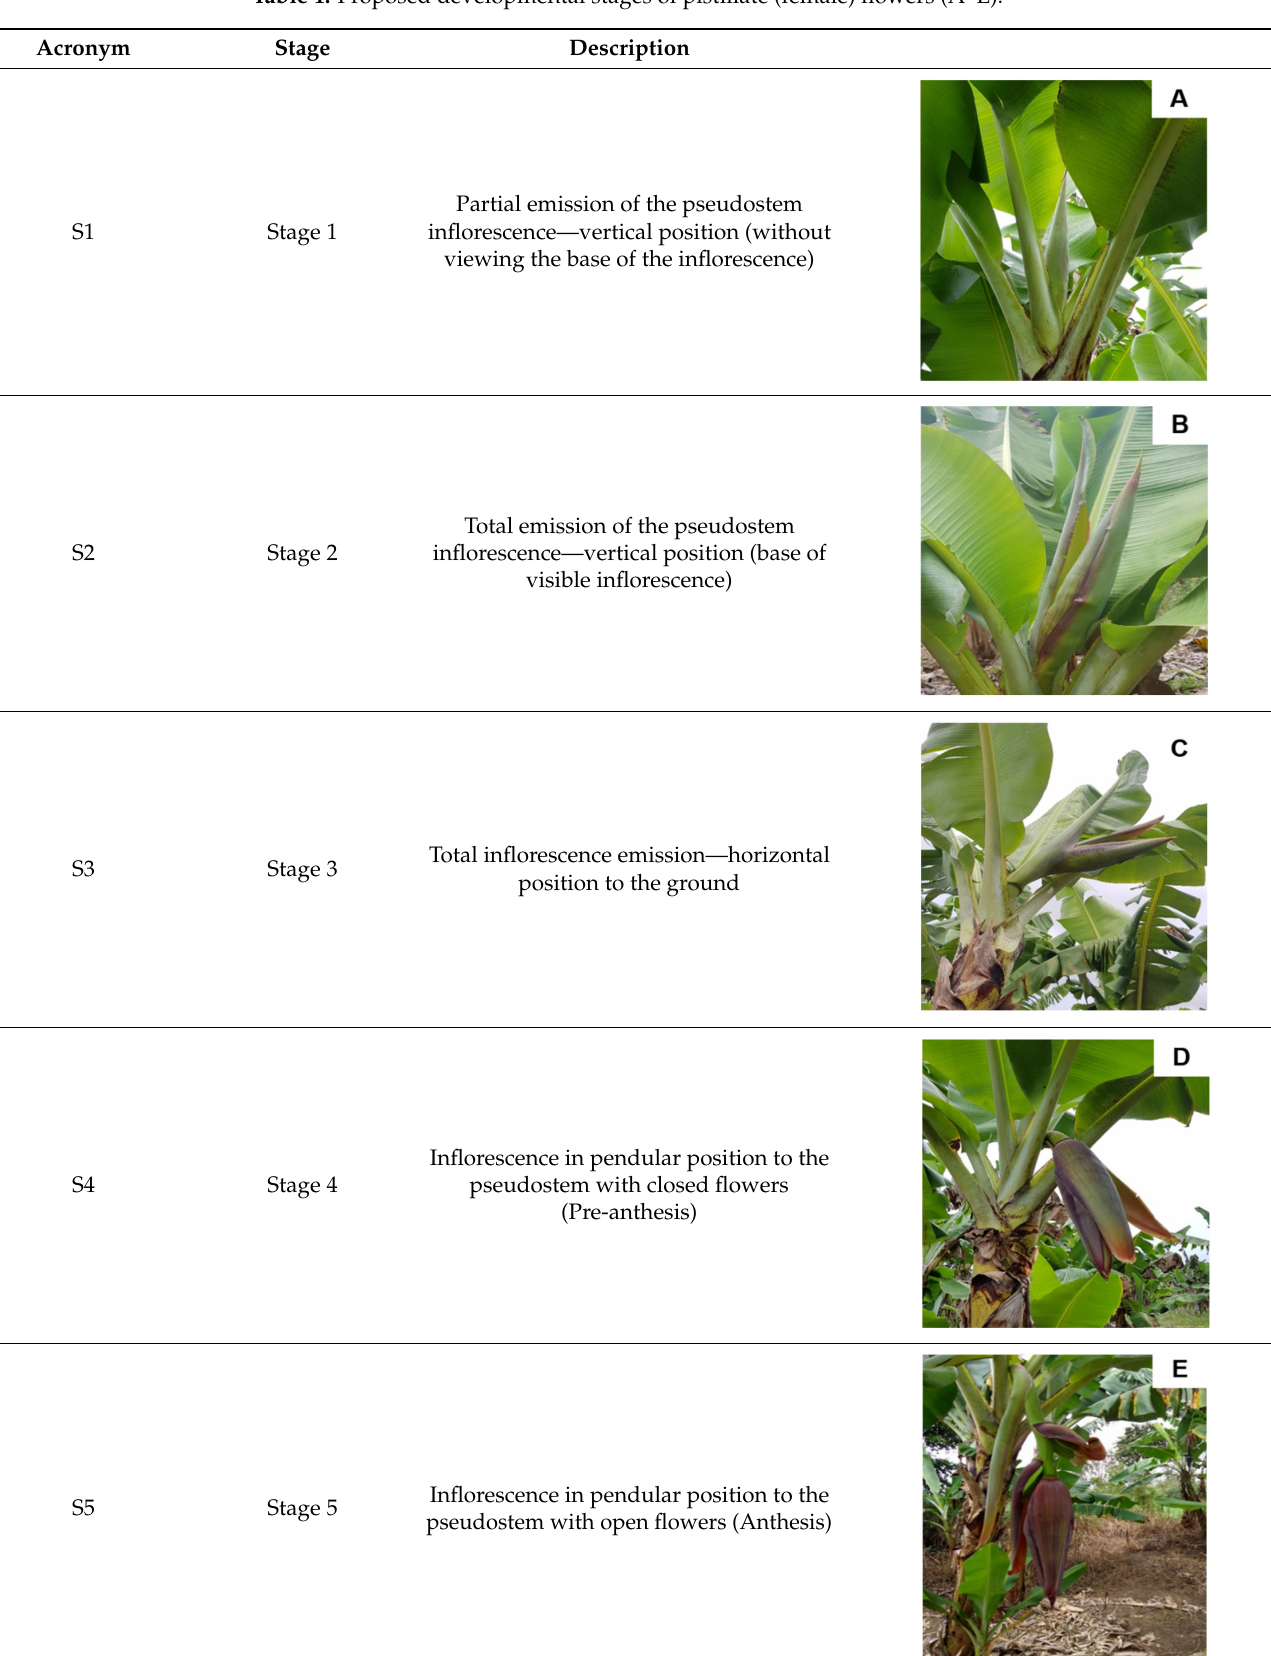
Table 1. Proposed developmental stages of pistillate (female) flowers